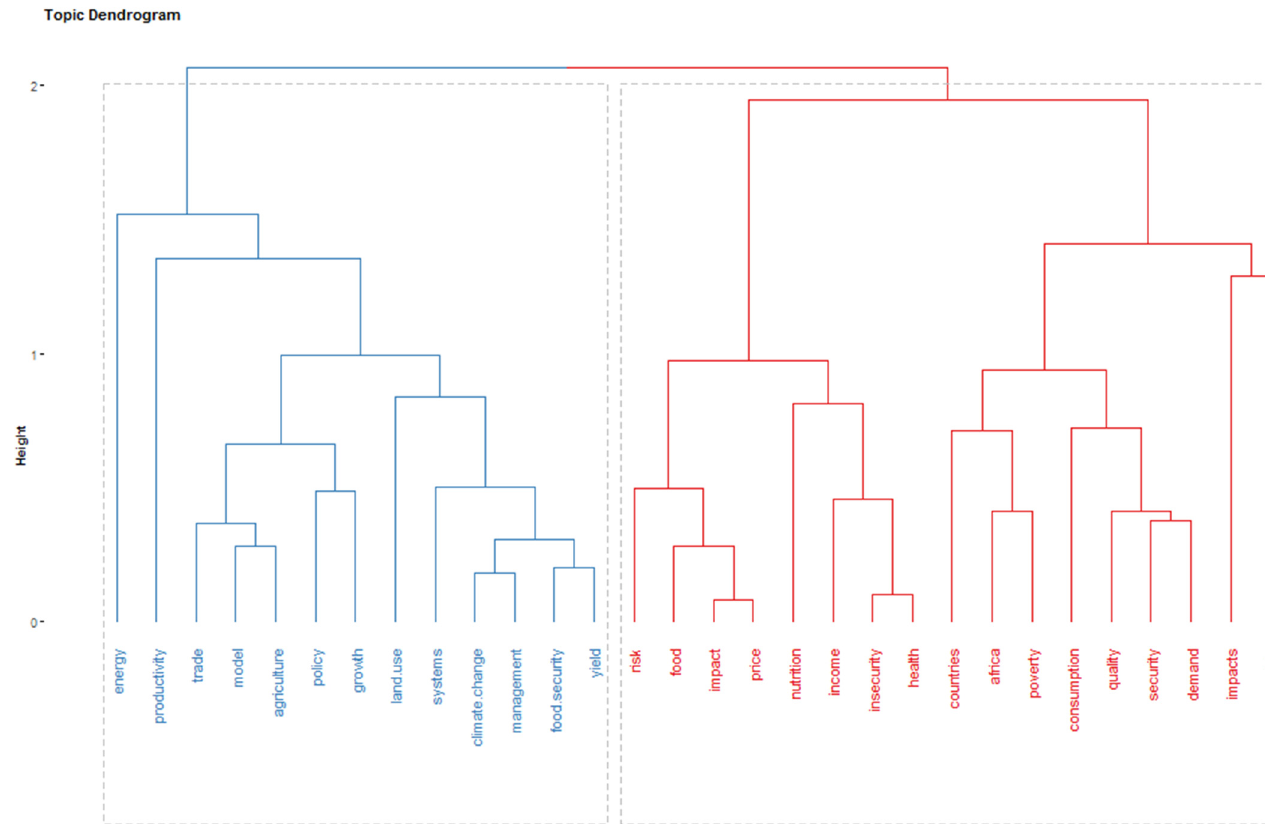
Figure 6. Keywords dendrogramusing a hierarchical clustering method. Source R studio results.